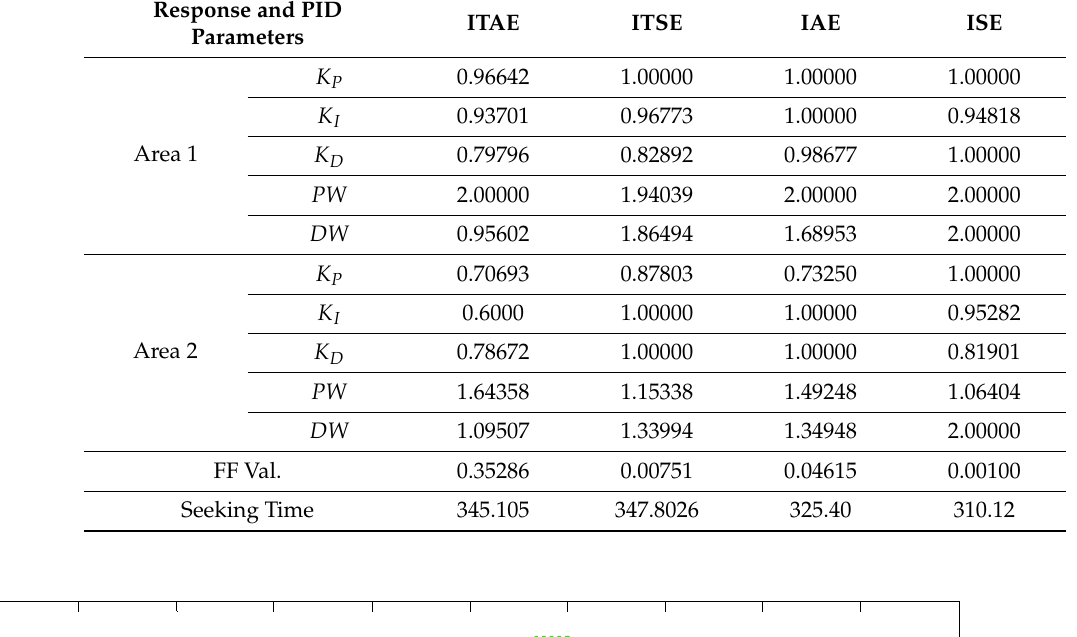
Table 6. Efforts of different performance criteria in the literature.